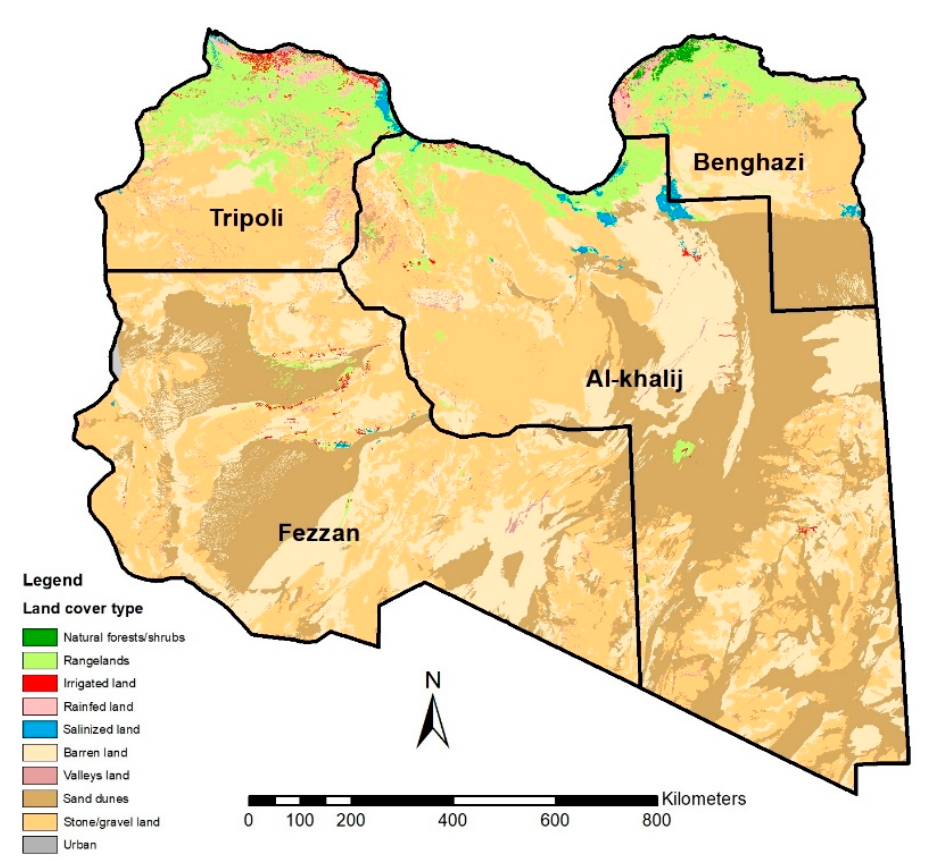
Figure 10. Map of the land cover type by Libyan territories (adapted from [13]). Table 14. Soil-related disservices and challenges by territories.